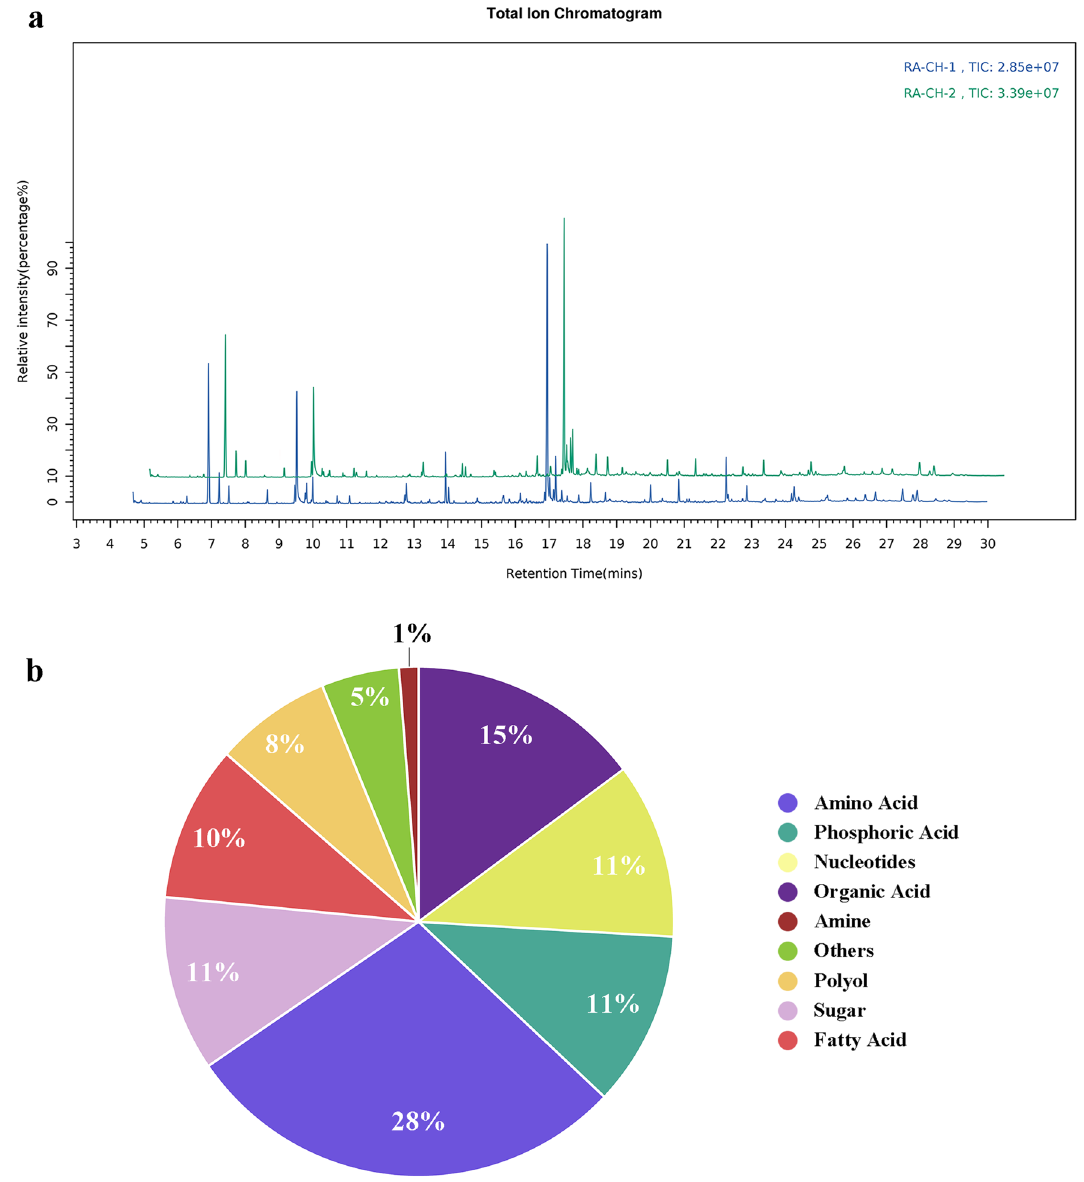
Figure 1. The metabolite profile of two RA species by GC–MS. ( a ) GC–MS total ion-chromatograms (TIC) of the typical metabolome samples from RA-CH-1 (blue) and RA-CH-2 (green) cultivated in TSB medium and sampled in the stationary growth phase. ( b ) Classification of 81 identified metabolites identified in